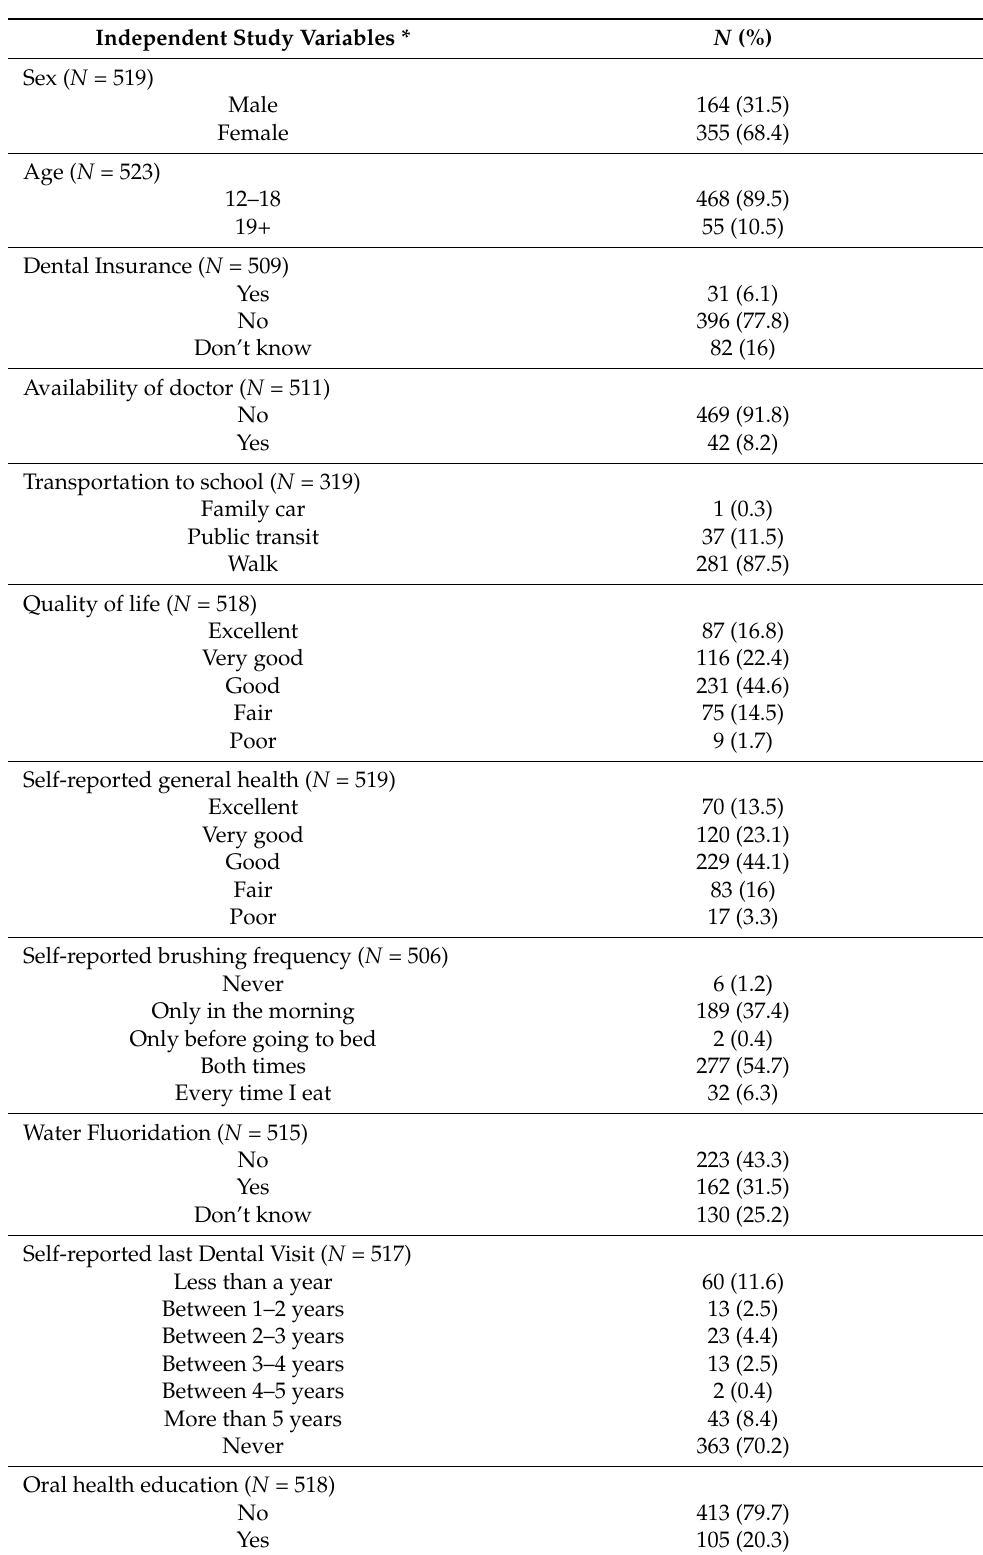
Table 1. Descriptive data demographic variables ( N =